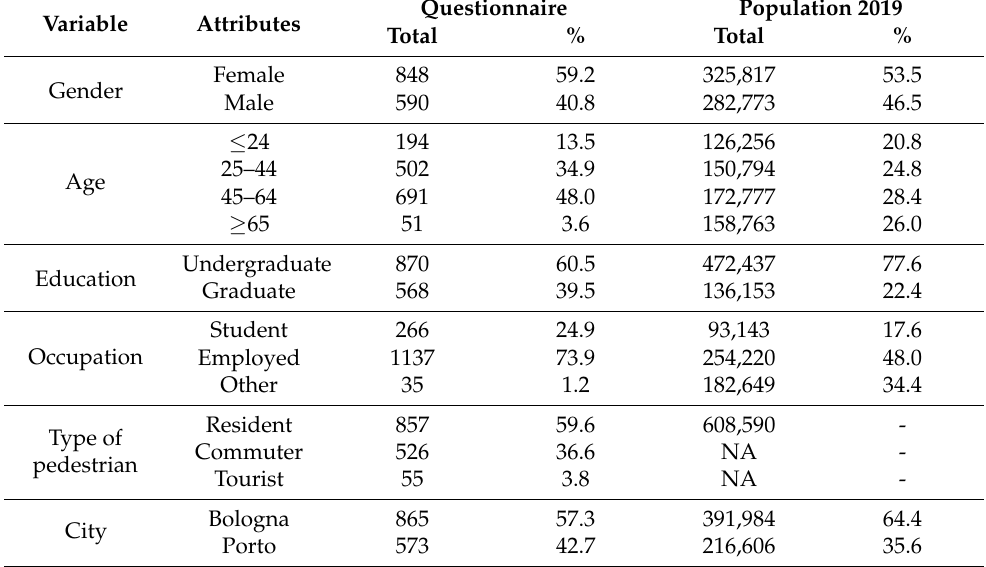
Table 1. Descriptive statistics of the